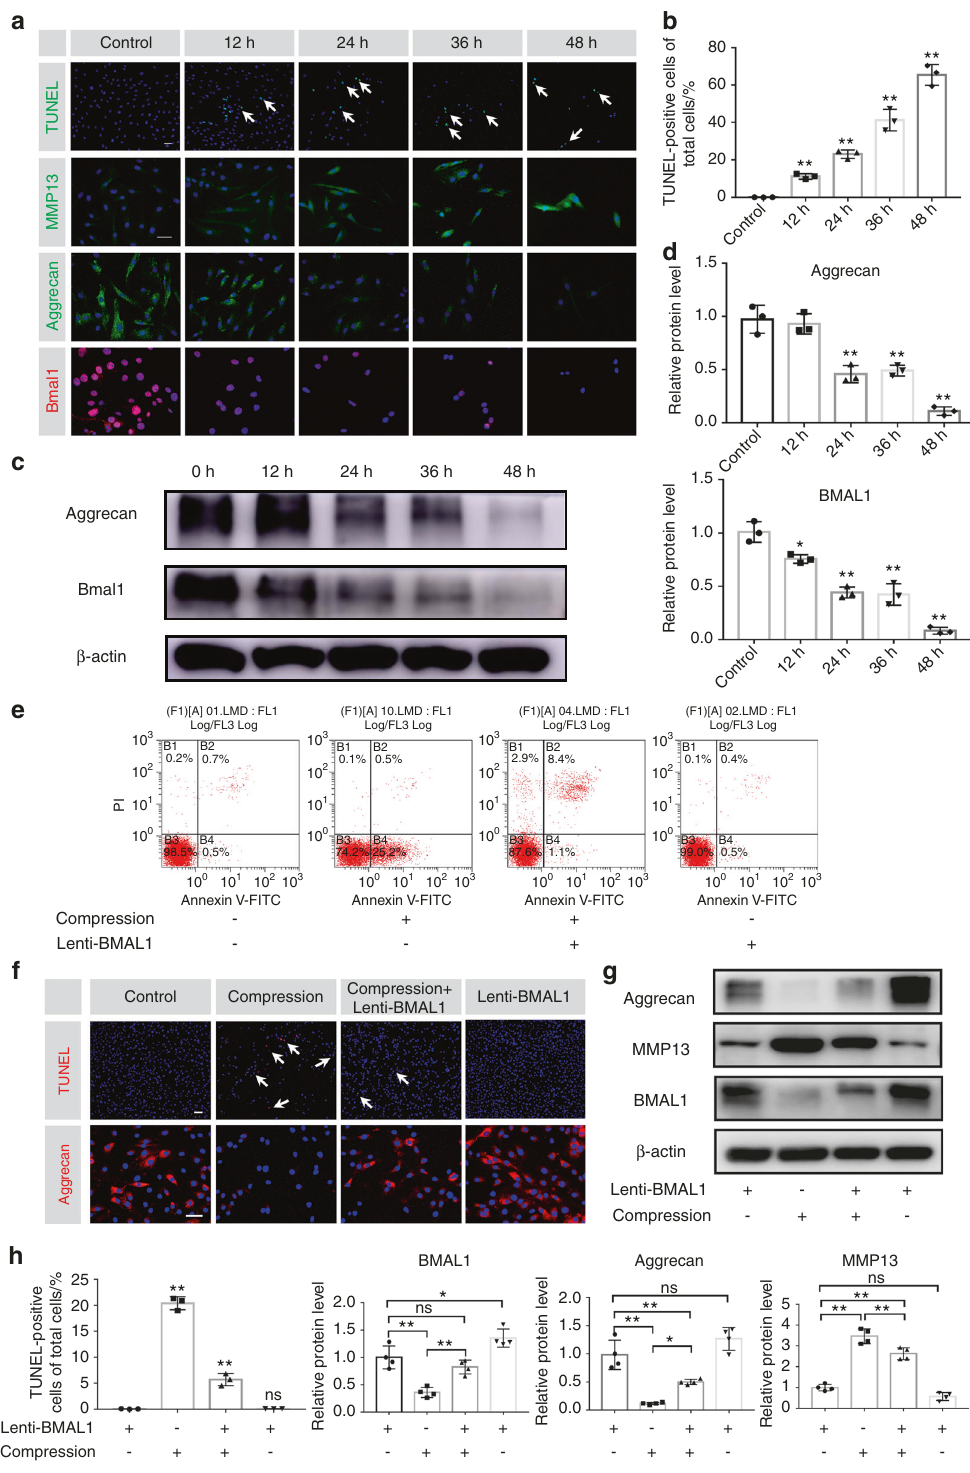
Fig. 3 Overexpression of BMAL1 prevents compression-induced NP cell apoptosis and dysfunction. NP cells were treated with 1.0 MPa compression for 0, 12, 24, 36 and 48 h, and some results are shown in the following graphs. a The expression of BMAL1, Aggrecan and MMP13 detected by immuno fl uorescence and apoptosis detected by TUNEL staining. Scale bar: 50 μ m. White arrows: TUNEL-positive cells. b Quanti fi cation of the percentage of TUNEL-positive cells. c, d The protein expression of Aggrecan and BMAL1 was detected by western blots in NP cells. The following graphs based on the experiments in which NP cells were subjected to Lent-BMAL1 transfection and then to 1.0 MPa compression for 0 and 24 h. e Representative dot plot of cell apoptosis by fl ow cytometry analysis after Annexin V/PI dual staining. n = 3. f The expression of Aggrecan detected by immuno fl uorescence and the apoptosis detected by TUNEL staining. Scale bar: 50 μ m. n = 3. White arrows: TUNEL-positive cells. g The protein expression of Aggrecan, MMP13 and BMAL1 was detected by western blot in NP cells. n = 4. h Quanti fi cation of the percentage of TUNEL-positive cells and the protein expression of Aggrecan, MMP13 and BMAL1. The data in the fi gures represent the mean ± S.D. ns not signi fi cant, ** P < 0.01, * P < 0.05, n = 3. Differences among multiple groups were analyzed by one-way